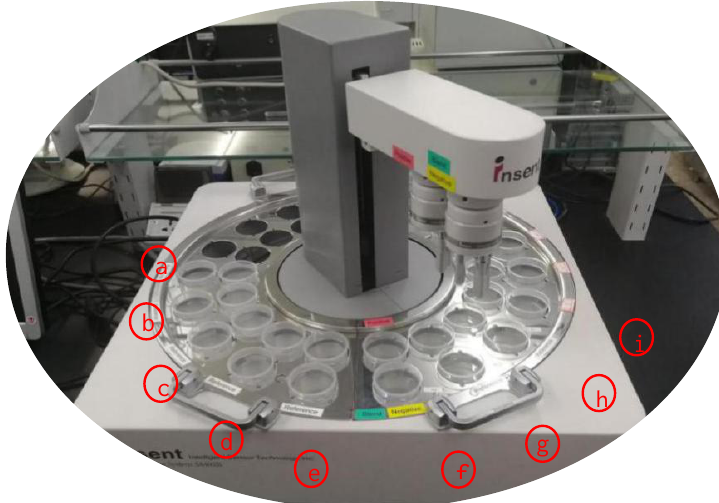
Figure 1. The SA-402B e-tongue system (a is used to measure the aftertaste value, b–c is used to quickly clean the sample, d–e is used to clean the positive and negative solution, f is the positive and negative cleaning solution, g is applied for sensor calibration, h is used for sensor reset, and i is liquor sample).